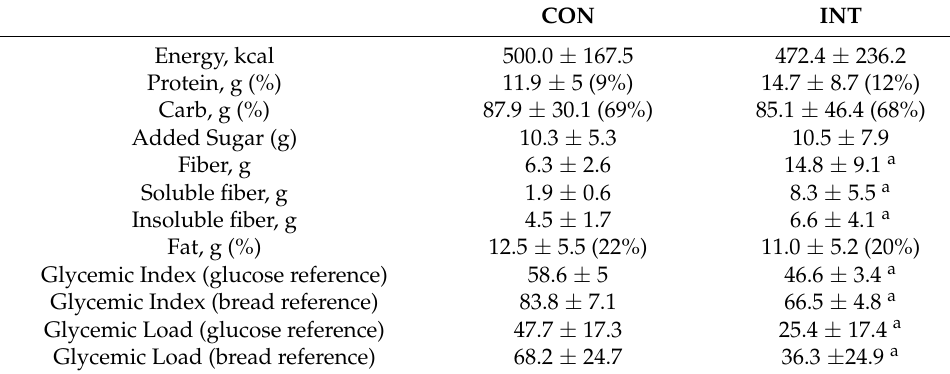
Table 2. Dietary characteristics of preschoolers on each